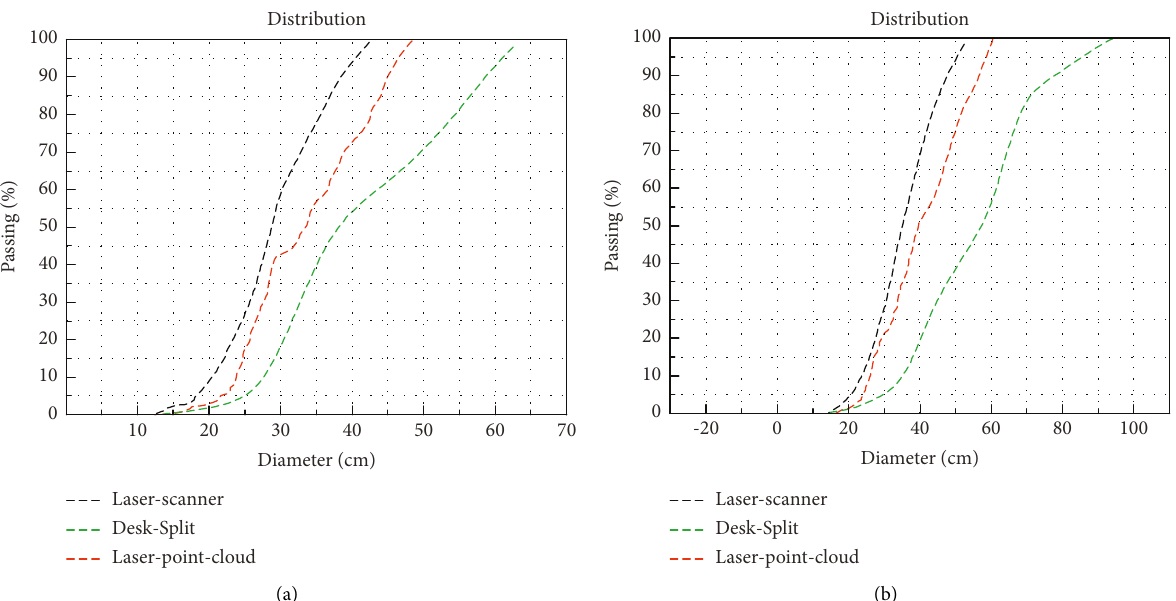
Figure 14: Size distribution of the stacked blocks including the information on the surface rock blocks. (a) Test 1. (b) Test 2.